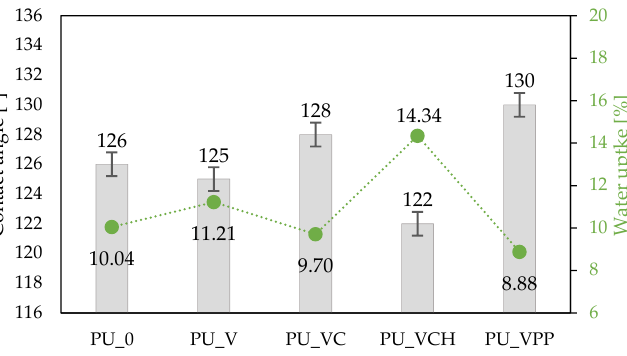
Figure 8. Selected properties of PU foams: contact angle and water uptake results.